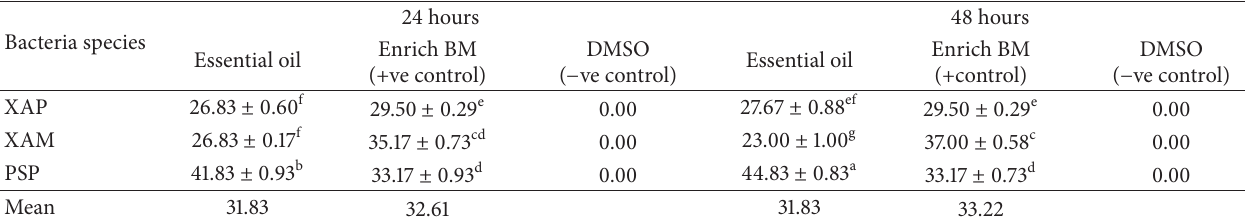
Table 1: Inhibition zones (mm) of Tagetes minuta essential oils and Enrich BM on three plant pathogenic bacteria after 24 and 48 hours. Bacteria species